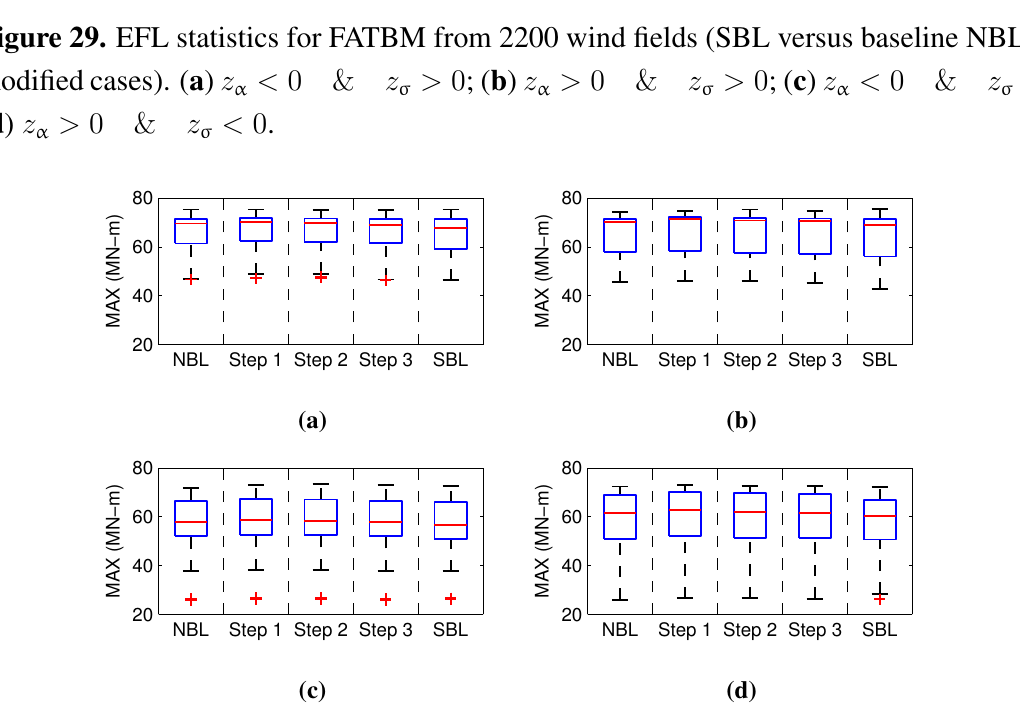
Figure 30. Ten-minute maximum statistics for FATBM from 2200 wind fields (SBL versus baseline NBL and modified cases). ( a ) z